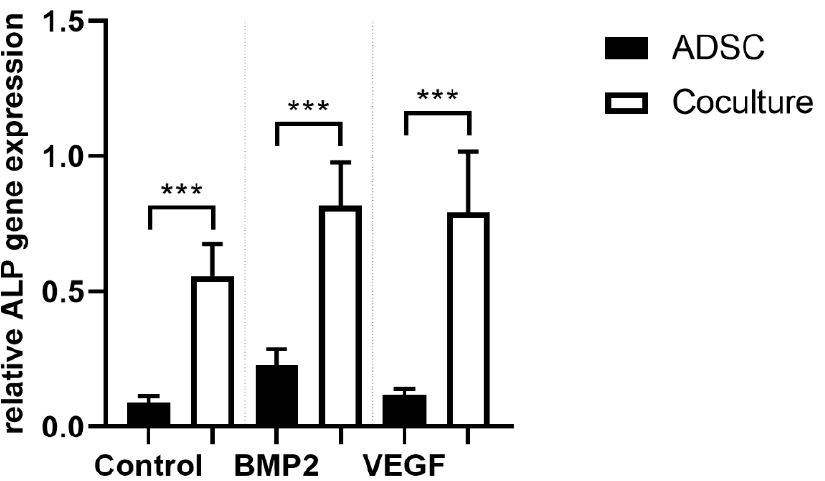
Figure 5. After negative immunoselection, PCR analysis was carried out in ADSCs. Alkaline phosphatase (ALP) gene expression as a surrogate parameter for osteogenic differentiation was upregulated under coculture conditions. BMP2 or VEGFA165 had no effect on ALP gene expression. Statistically significant differences between the experimental groups are indicated for *** p ≤ 0.001.